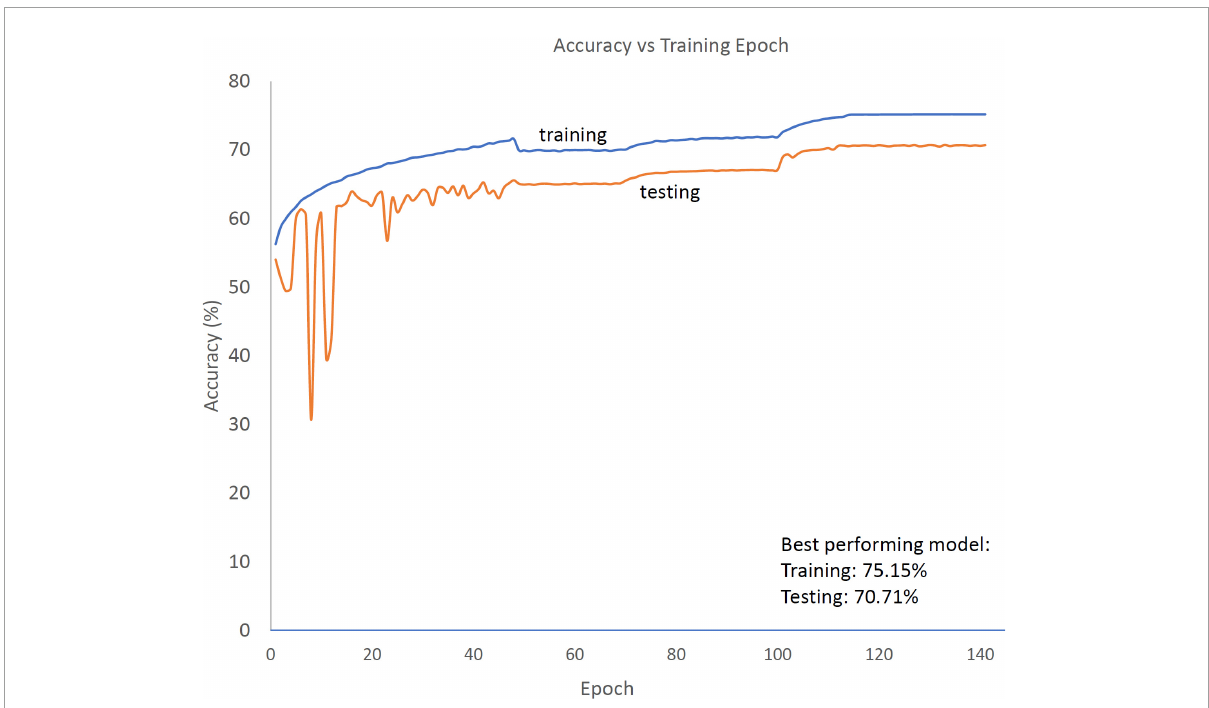
FIGURE1 Trend of accuracy in the training (blue solid line) and testing (orange solid line) datasets as a function of training epochs for the 4-level model. Following an initialization period (for epoch value < ∼ 50), the difference in performance between the training and testing sets stabilizes at ∼